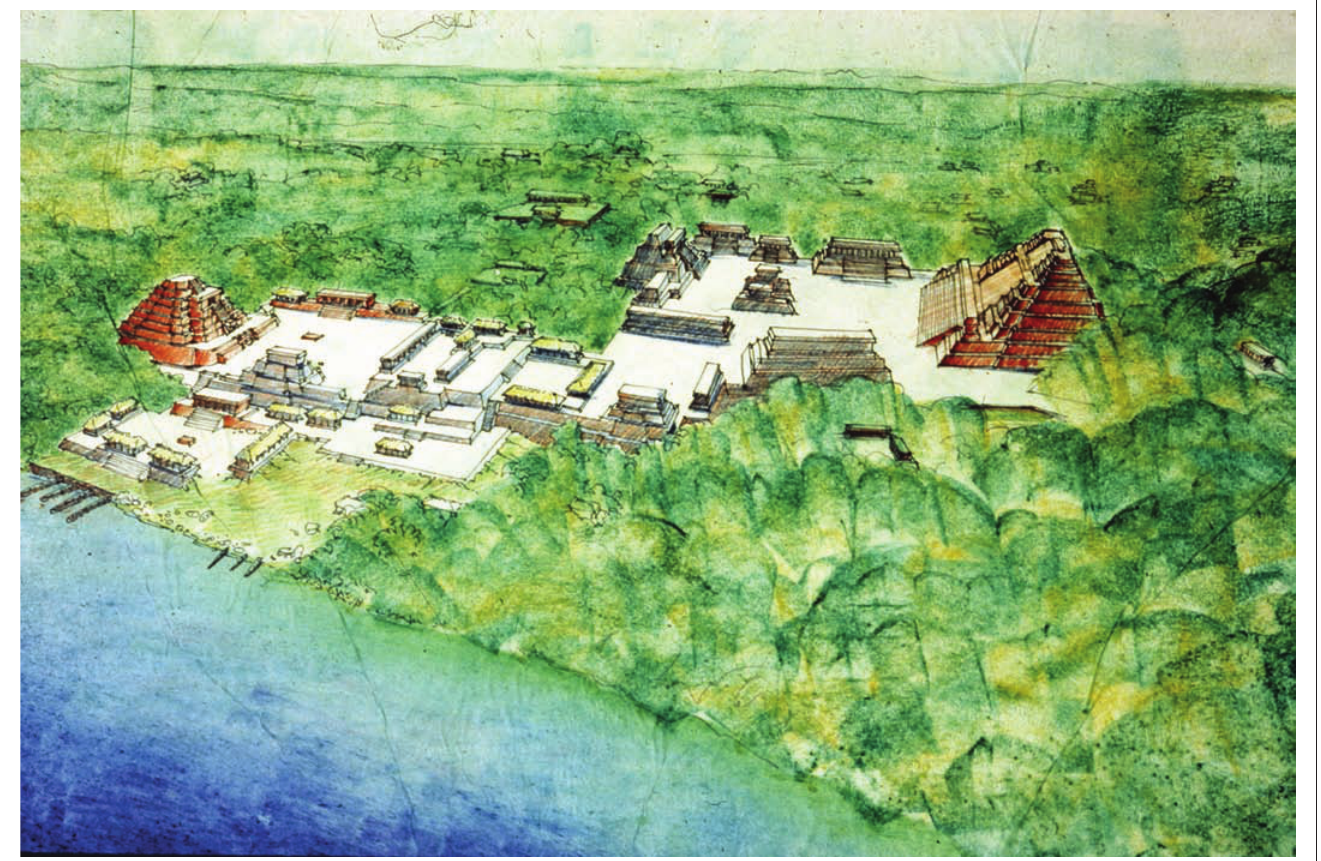
Figure 3 Reconstruction of Lamanai by H. S.